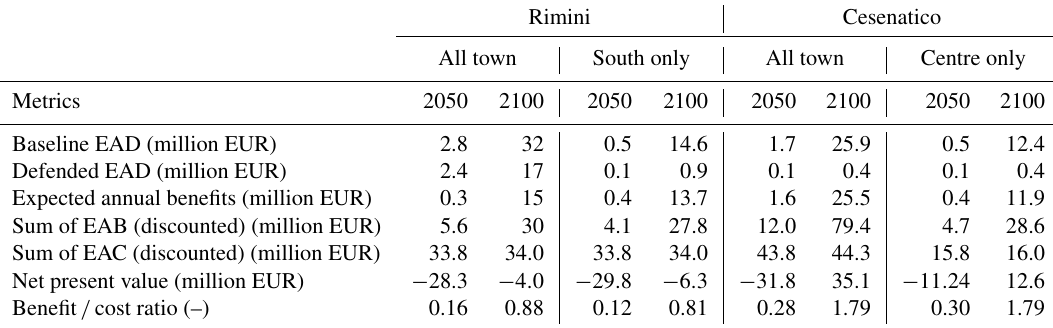
Table 2. Summary of CBA for planned or designed seaside defence project in Rimini (all town and south section only) and Cesenatico (all town and centre only) over a time horizon of 30 and 80 years (2021 to 2050 and 2021 to 2100).